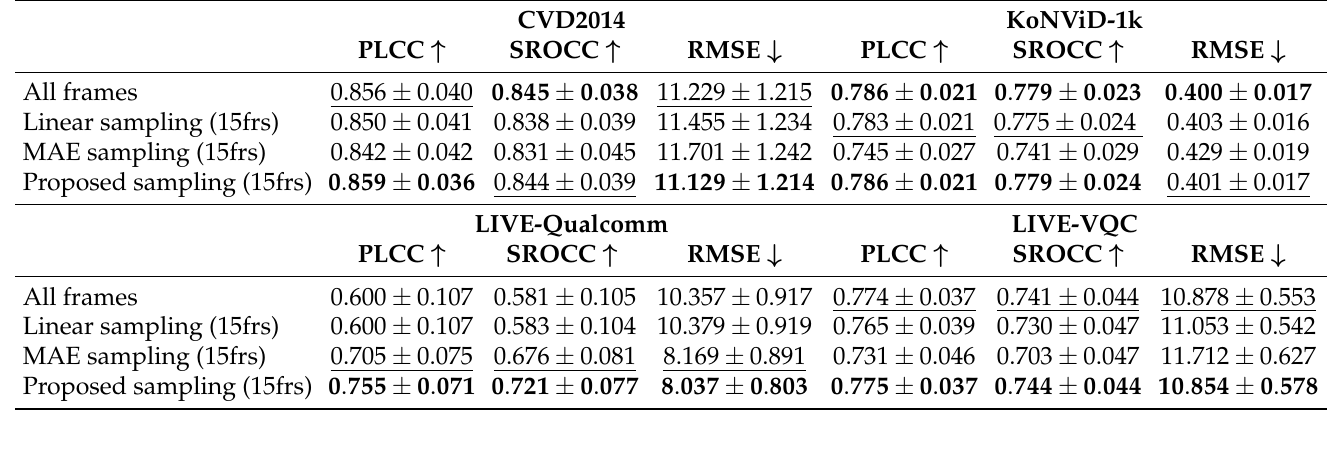
Table 5. Mean PLCC, SROCC, and RMSE across 100 train–test combinations on the four considered databases using different sampling methods. In each column, the best and second-best values are marked in boldface and underlined, respectively.